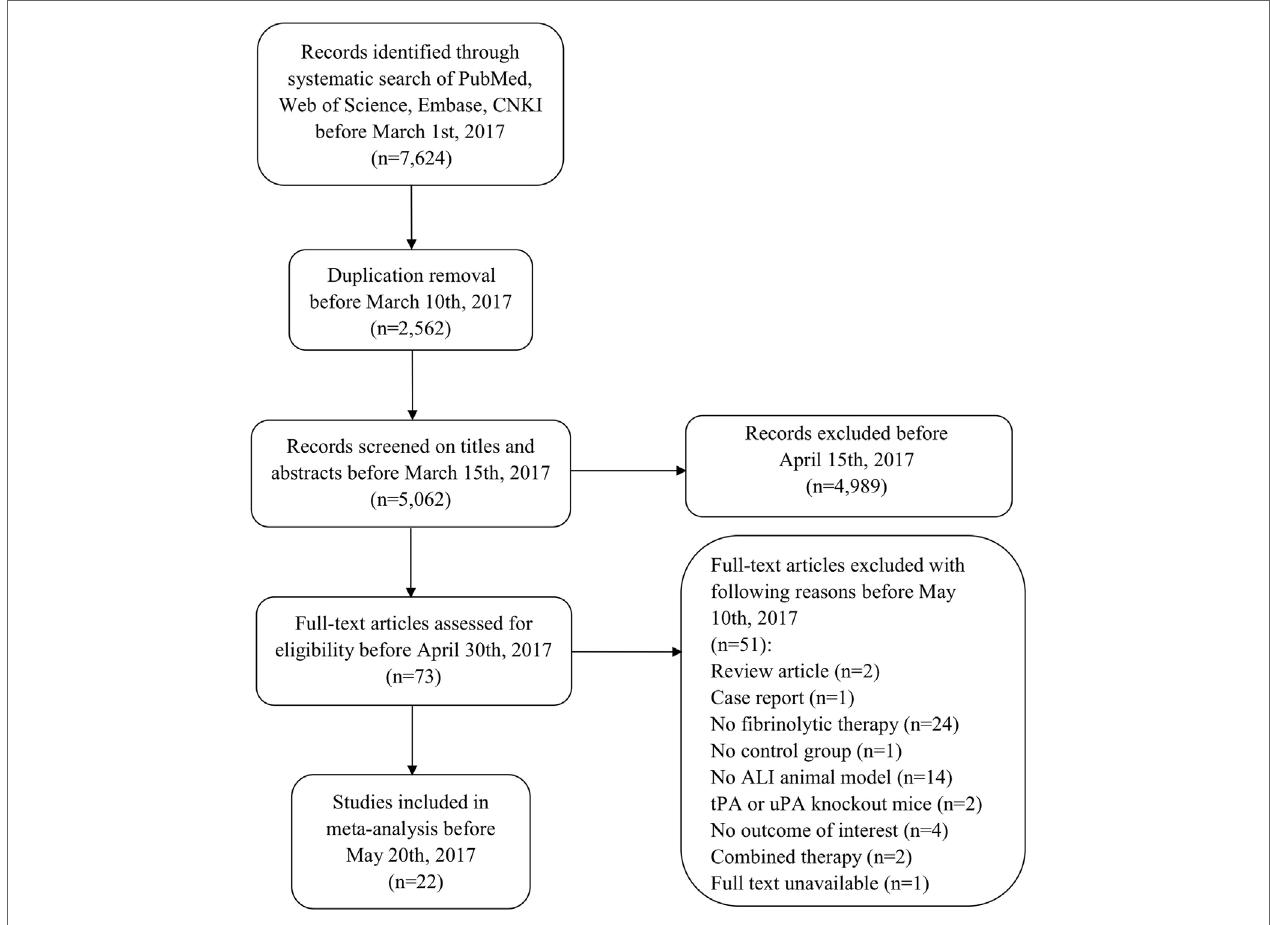
FiGURe 1 | Flow diagram of the literature search and